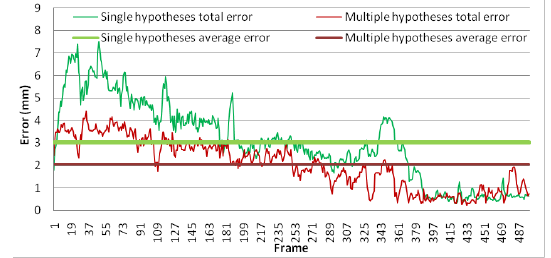
Figure 15. SH instability (top) and MH stability (bottom).